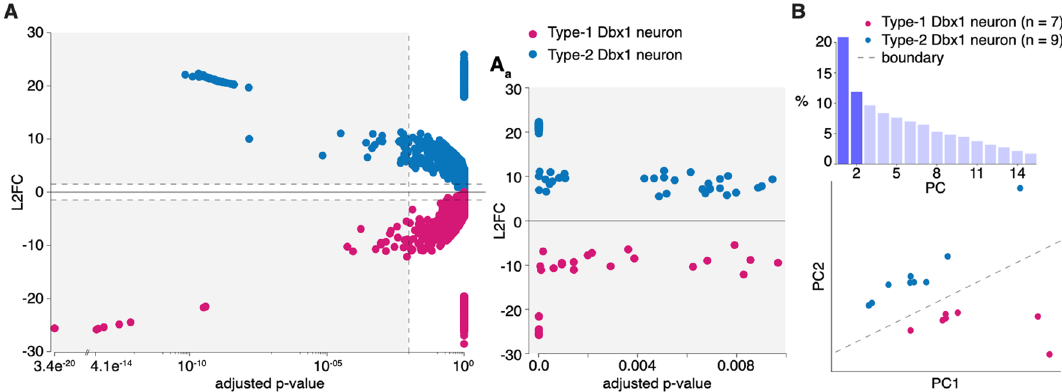
Figure 2. Transcriptomic differences in Type-1 and Type-2 neurons. ( A ) L2FC versus adjusted p values of 31,543 genes computed using DESeq2. Genes upregulated in Type-1 are in magenta and those upregulated in Type-2 are in blue-cyan. Gray shaded area represents the region expanded in ( A a ), which corresponds to L2FC > 1.5 and p adj < 0.01. ( B ) Bar chart (top) shows PCs (x-axis) and variability (y-axis) in the expression of 123 DE genes. Scatter plot (bottom) shows clustering of Type-1 (magenta) and Type-2 (blue-cyan) neurons using the first two PCs (highlighted in dark violet at top). The gray dashed line shows the boundary between the clusters of Type-1 and Type-2 neurons drawn by